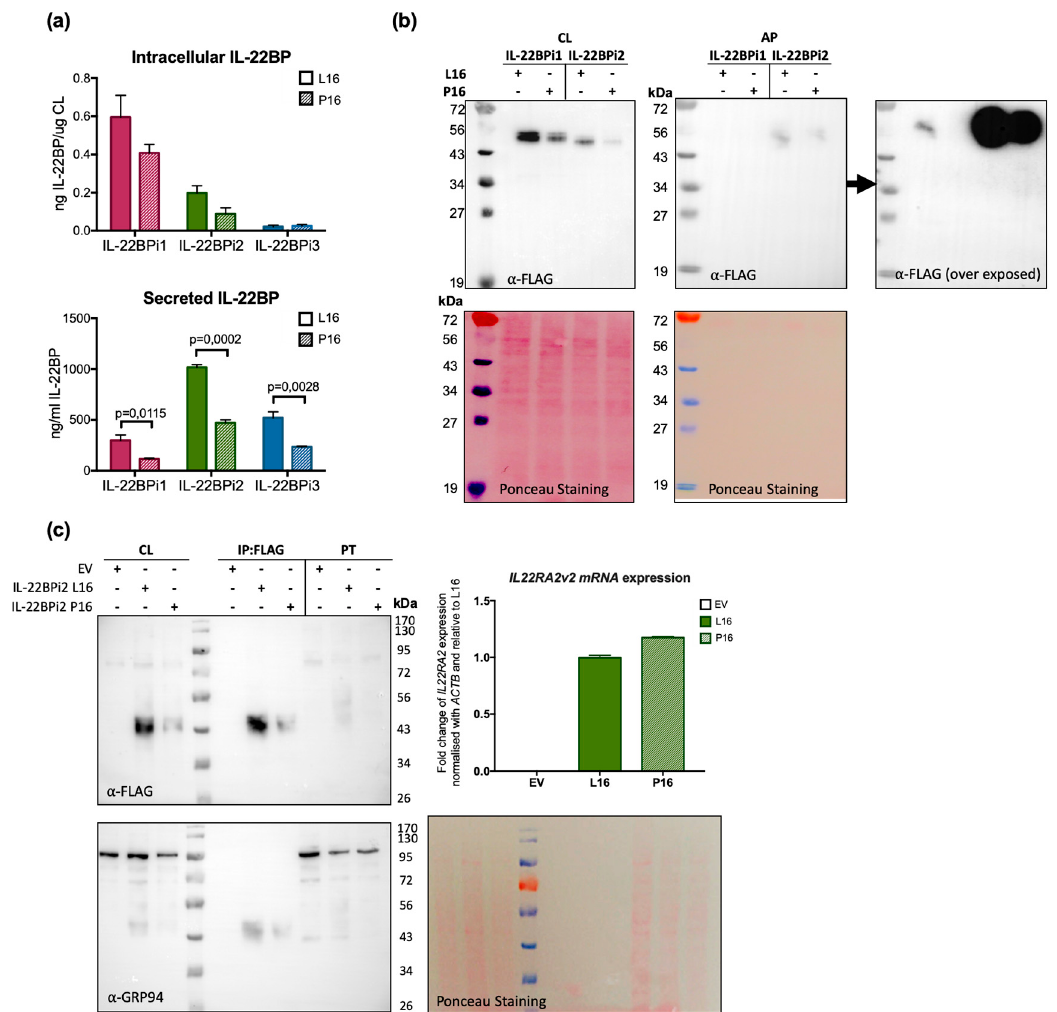
Figure 4. The Pro16 variant in the SP of the three IL-22BP isoforms is associated with decreased secretion levels compared to the Leu16 variant. ( a ) HEK293 cells were transfected with the indicated expression plasmids, 24 h later cells were lysed and the conditioned medium collected. Intracellular and secreted IL-22BP isoform protein levels were measured by ELISA (mean ± SEM; n = 3; p -values by unpaired t -test). ( b ) HEK293 cells were transfected with the indicated expression plasmids, 24 h later cells were lysed and the conditioned medium was subjected to acetone precipitation (AP). Both cell lysates (CL) and AP were resolved by SDS-PAGE under non-reducing conditions and immunoblotted against FLAG (Ponceau staining served as loading control). For AP, the immunoblot membrane was subjected to longer exposure times. ( c ) HEK293 cells were transiently transfected with the indicated expression vectors (EV denotes empty vector), 24 h later cells were lysed and RNA purified. Intracellular IL-22BP protein was immunoaffinity-purified with FLAG agaroses and detected by WB following FLAG purification and in cell lysates (CL) and pass through fraction (PT). GRP94 detection and Ponceau staining served as loading controls. Transfection efficiency was measured by IL22RA2 RT-qPCR relative to the housekeeping gene ACTB. Mean ± SEM of three technical replicates. Note that as previously observed [20], immunoreactive bands corresponding to intracellular IL-22BP isoforms appear as a series of 43 to 56 kDa bands due to differential N -glycosylation, with secreted IL-22BPi2 gaining ~8 kDa (56 vs. 48 kDa) due to complex N -glycosylation.